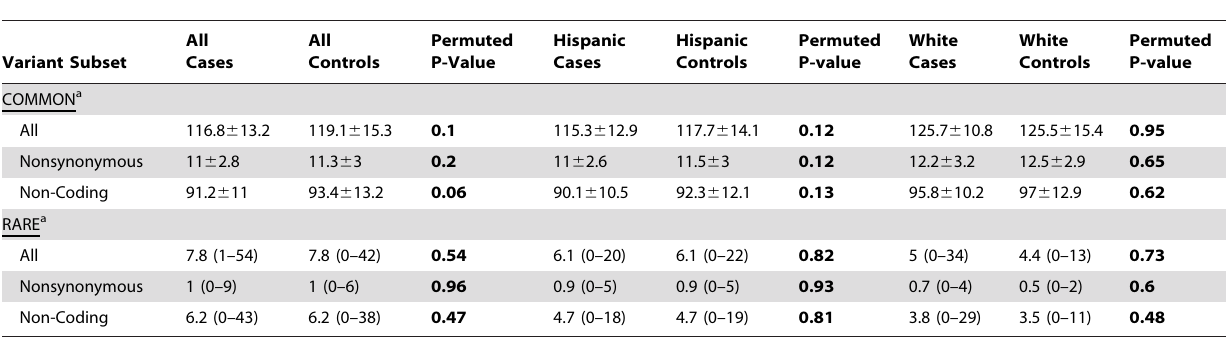
Table 2. Mean Number of Minor Alleles from 31 Folate Pathway Genes in Cases vs. Controls for Different Variant Subsets.